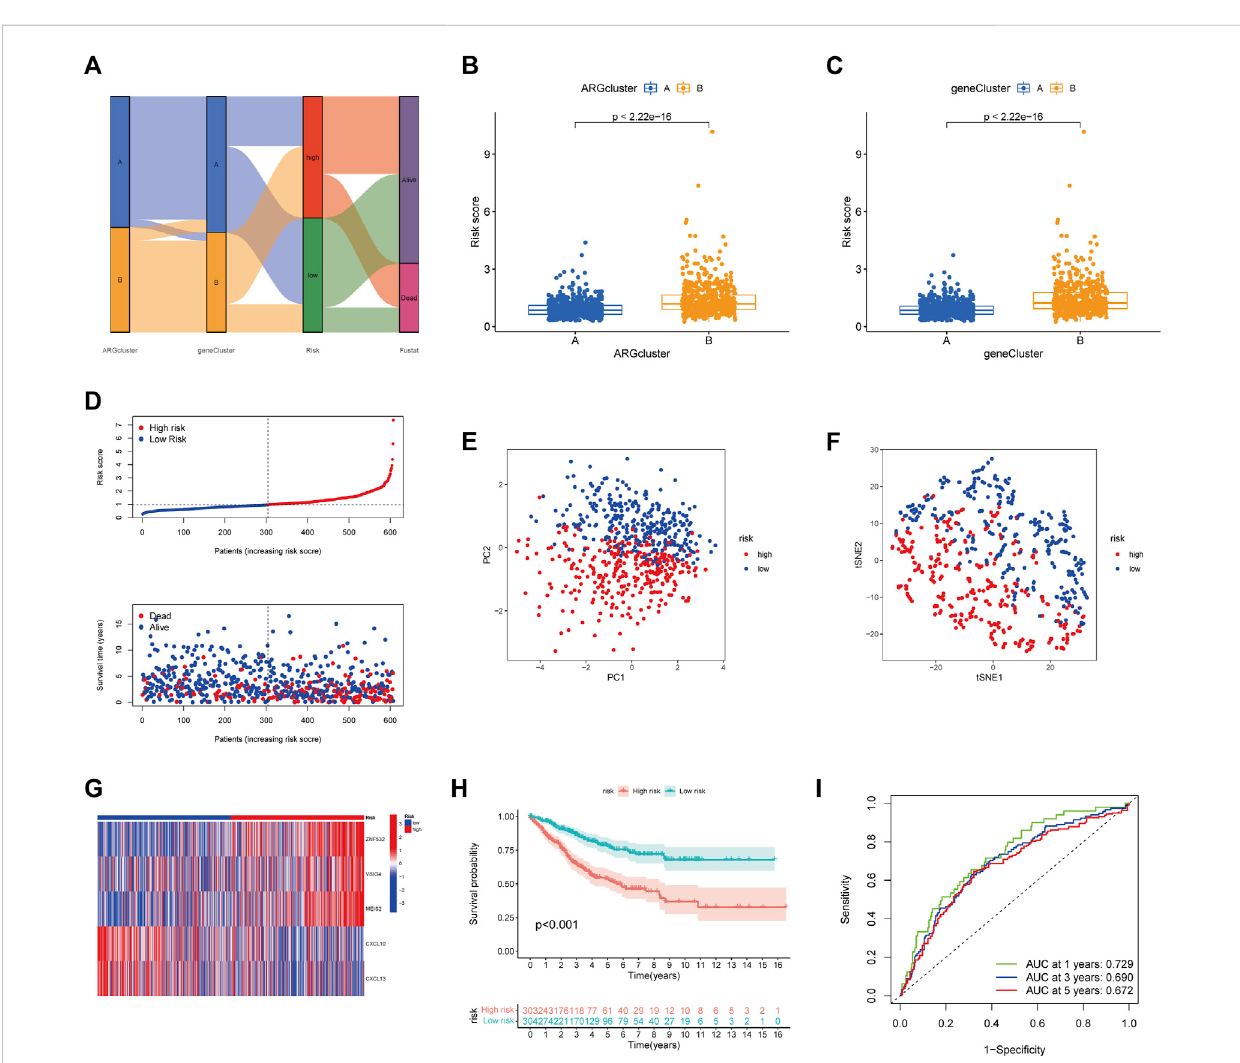
FIGURE 5 Construction of ARGscore in the train set. (A) Alluvial diagram of the subgroup distribution of different ARGscore and survival outcomes. (B) Differences in ARGscore between angiogenesis subtypes. (C) Differences in ARGscore between gene subtypes. (D) Ranked dot and scatter plots displayed thedistributionofARGscoreandthesurvivalstatusofpatients. (E,F) The PCAandt-SNEanalysis demonstratedthatthepatientsinthedifferent riskgroupsweredistributedintwodirections. (G) Expressionheatmapof fi veprognosticgenesofthemodelinhigh-andlow-ARGscoregroups. (H) K-M analysis of OS between the two subgroups (Log-rank, p < 0.001) (I) ROC curves for predicting survival and sensitivity at 1, 3, and 5 years based on